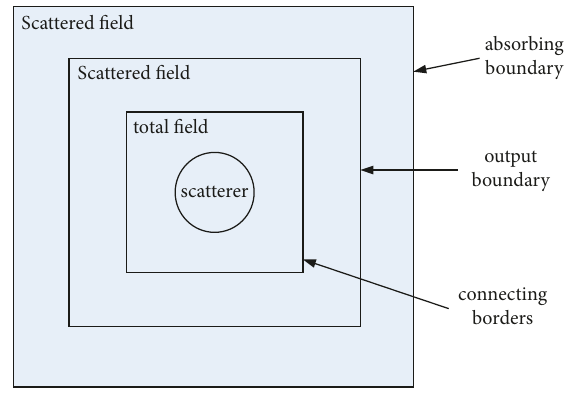
Figure 5: FDTD region division for the scattering